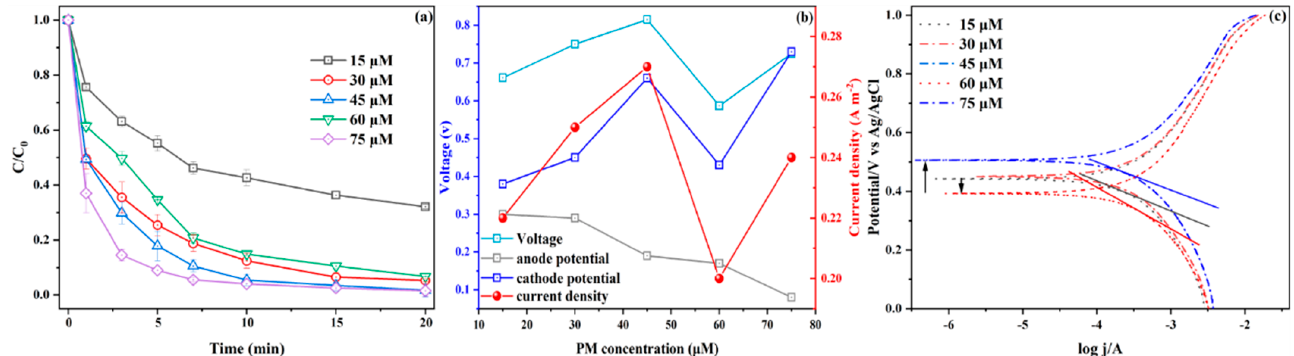
Figure 2. The DCF removal ratio ( a ), the change of voltage, cathode/anode potential, and current density ( b ), and Tafel curve ( c ) in different PM concentrations (pH = 3.0; [DCF] 0 = 60 µM; external resistances = 0 Ω ).